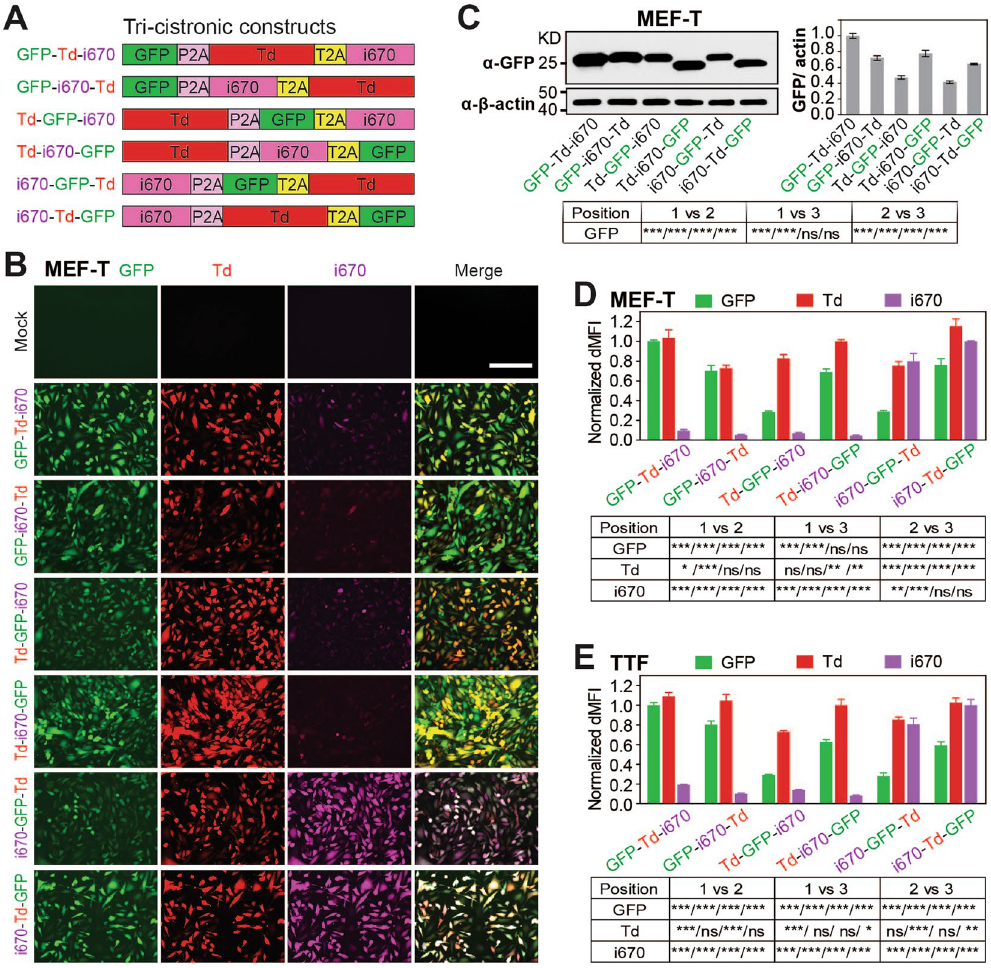
Figure 3. Tri-cistronic 2A constructs: positional effects on gene expression. ( A ) Tri-cistronic constructs in a P2A-T2A backbone expressing three FPs GFP, Td and i670 in different orders. ( B and C ) MEF-T cells were transduced with retroviruses (pMXs) encoding the different 2A constructs for 3 days. Live fluorescent images of these cells were taken at 20X ( B ) and then cells were collected for ( C ) western blotting analysis for GFP expression, or ( D ) flow cytometry analysis for dMFI of GFP (green bar), Td (red bar), and i670 (purple bar). ( C ) GFP was quantified and normalized to the β -actin loading control. ( D ) dMFI was normalized to that of GFP- Td-i670 for GFP, Td-i670-GFP for Td, and i670-Td-GFP for i670. ( E ) The same as ( D ) except performed in TTF. Mean ± SEM of multiple experiments were shown. Results from one-way ANOVA and bonferroni correction were summarized in a table. Scale bar = 200 µ